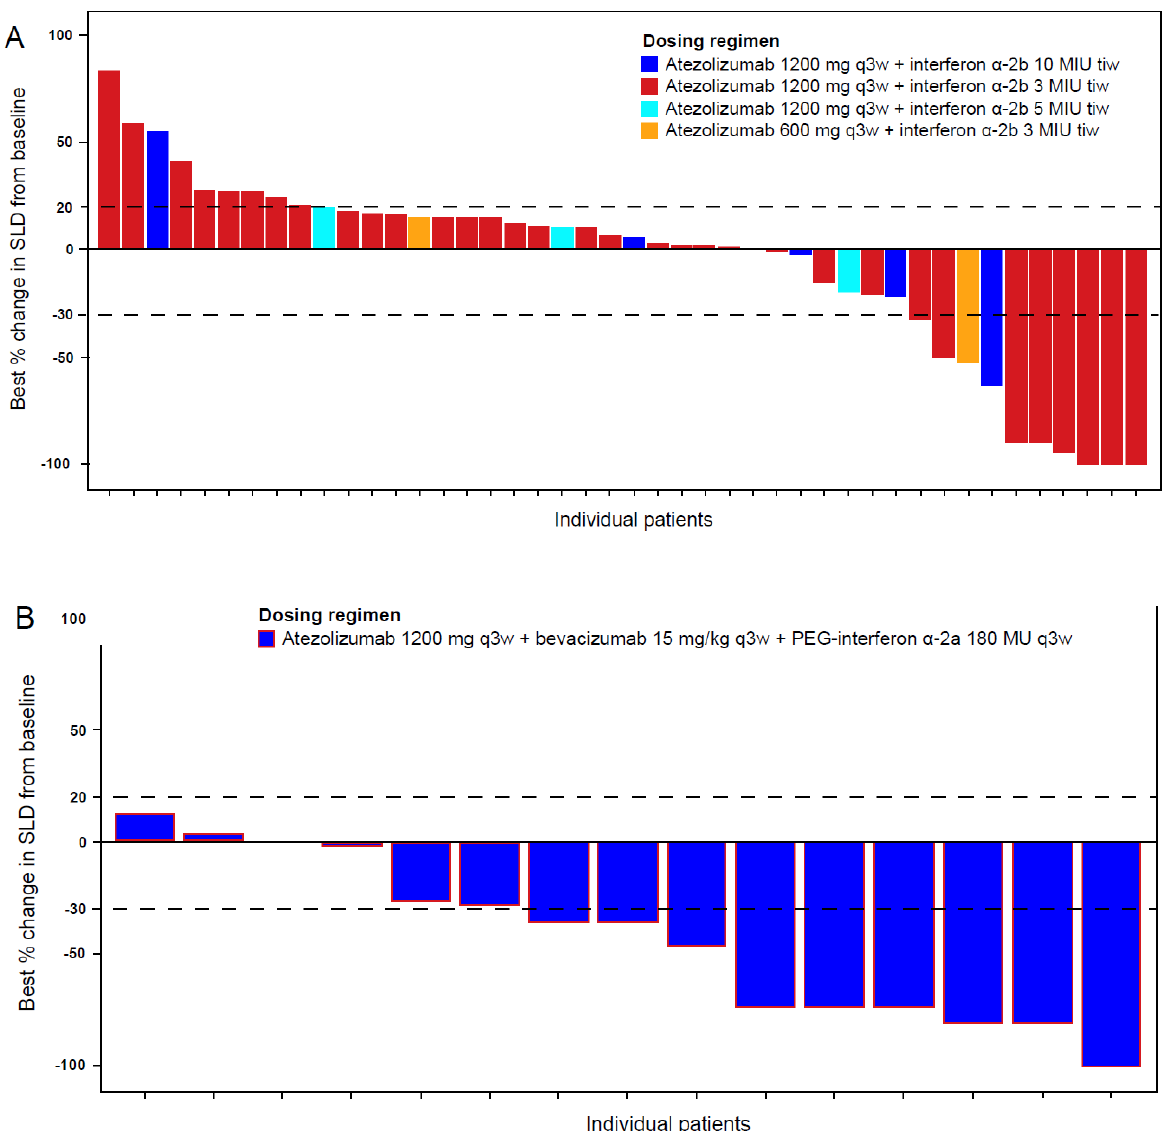
Figure 2. Best percent changes from baseline in target lesion size for individual patients. ( A ), Best percentage change from baseline in SLD in Arm B patients with RCC and no prior CPI. ( B ), Best percentage change from baseline in SLD in Arm D Cohort 1 patients with previously untreated RCC. Dashed lines indicate +20% and −30% values use to categorize RECIST response status. MIU, million international units; q3w, every 3 weeks; SLD, sum of longest diameters; tiw, three times per week.